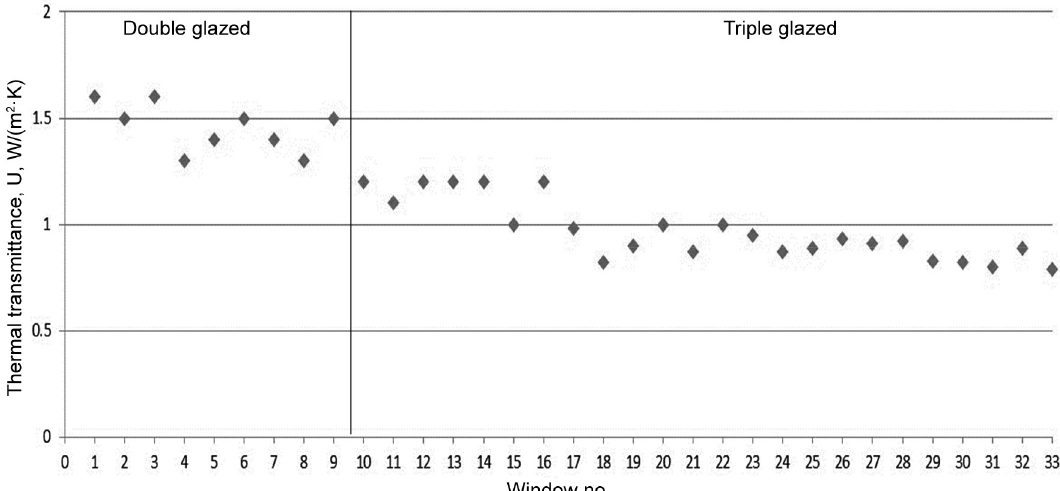
Figure 8. Thermal transmittance of windows